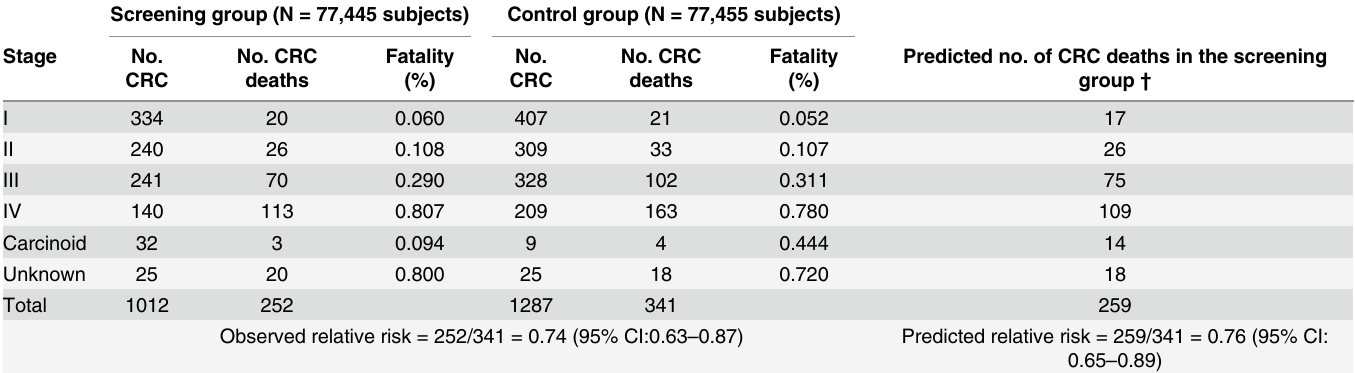
Table 2. Reported and predicted risk of colorectal cancer (CRC) death in the PLCO trial * . Screening group (N = 77,445 subjects)